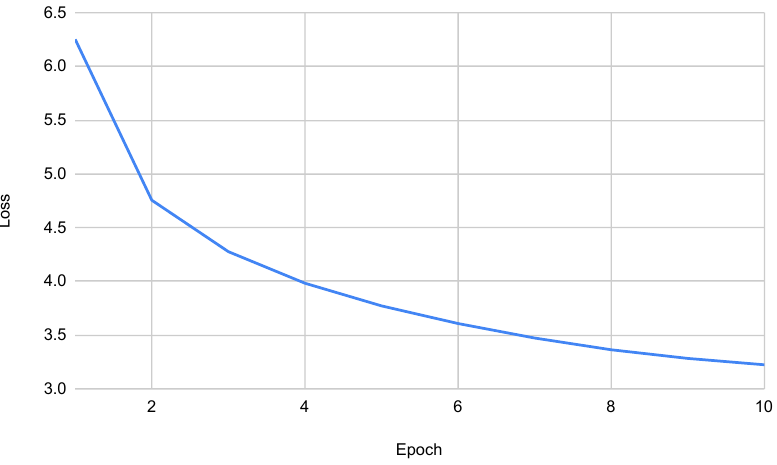
Figure 5. PaloBERT language model training loss.